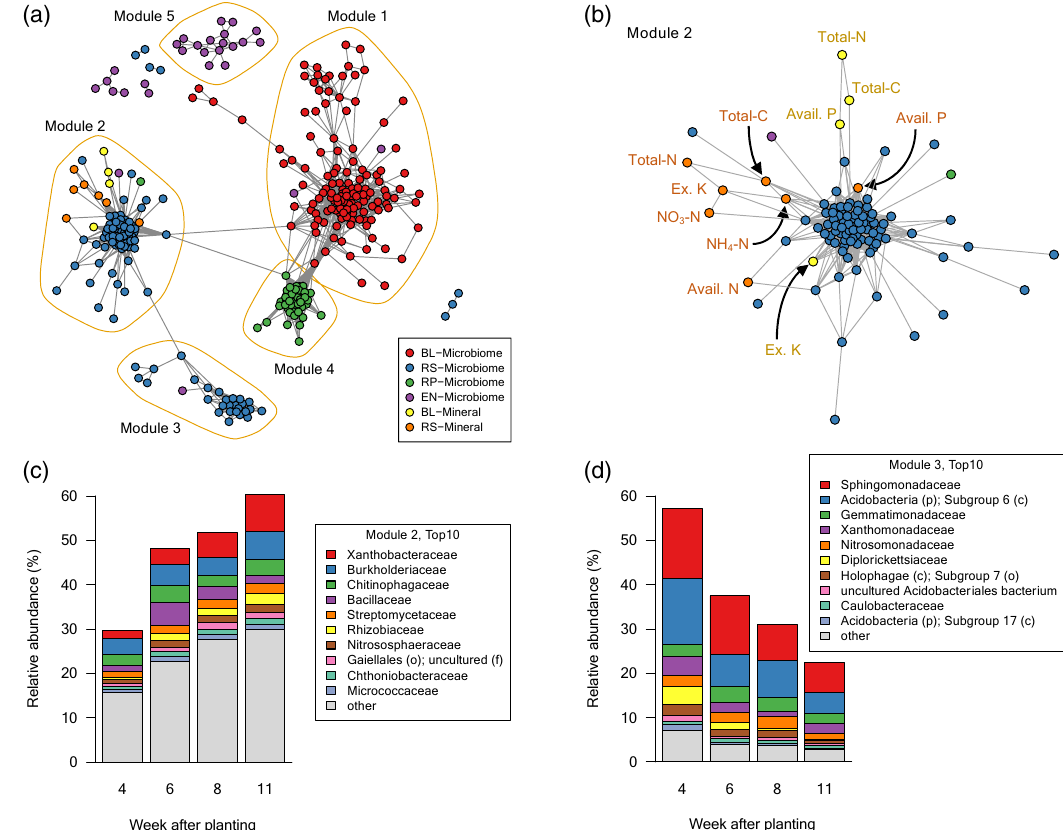
Figure 10. Co-abundance network among soil minerals and bacterial taxa at the family levels in root-associated compartments. ( a ) Co-abundance network constructed based on the correlation. Four networks in four growth stages were merged, and the consistent network at all growth stages were extracted. Modules were found based on the fast greedy modularity optimization algorithm. Nodes represent bacterial taxa at the family level and mineral components, and edges are drawn based on the topological overlap. ( b ) Sub-network of the Module 2. ( c ) Relative abundance of taxa belonging to the Module 2 in the rhizosphere. ( d ) Relative abundance of taxa belonging to the Module 3 in the rhizosphere. BL, bulk soil; RS, rhizosphere; RP, rhizoplane; EN, endosphere; Avail, available; Ex,